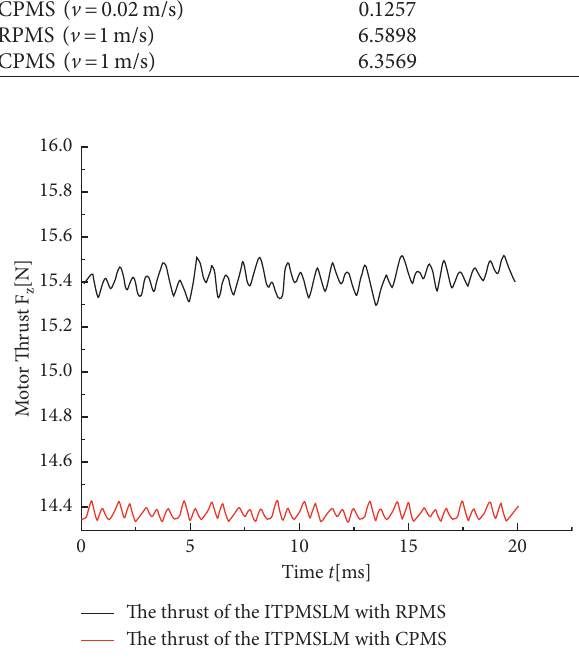
Figure 18: Thrust distribution of CPMS and RPMS.